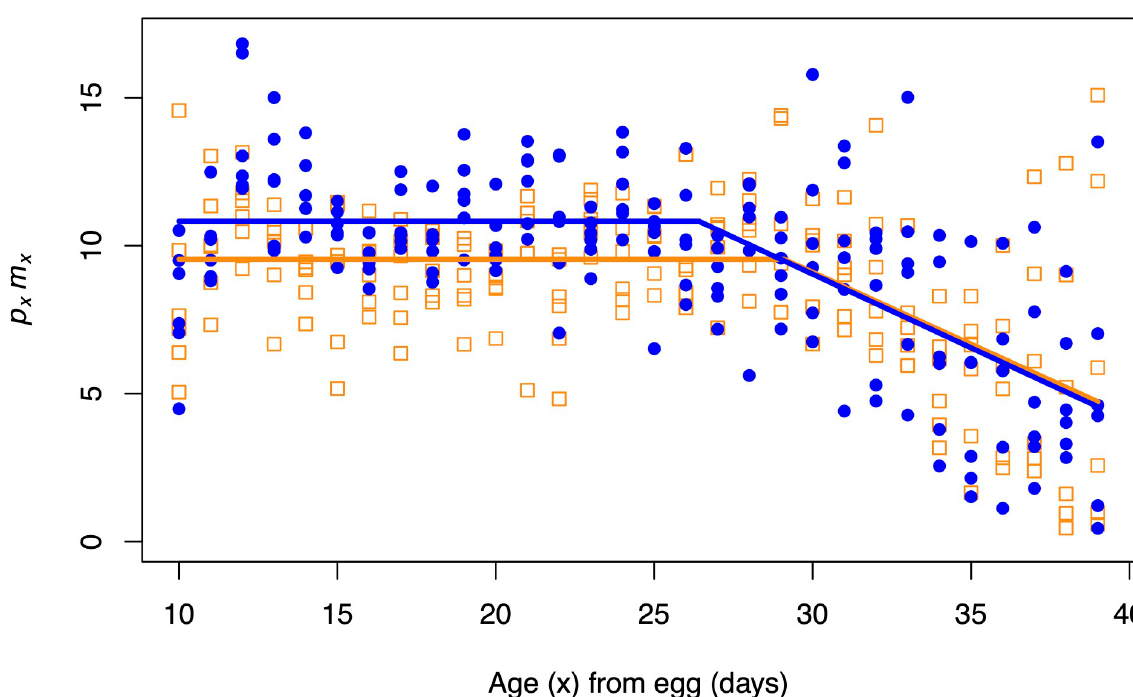
Fig 3. p results for the three ACO populations on the banana and orange diets. Closed blue circles and solid blue lines represent data x m x and regressions from the banana diet. Open orange squares and dotted orange lines represent data and regressions from the orange diet. A significant difference between diets in the intercept from the first stage ( a 0 ) was observed with flies on the orange diet not performing as well compared to the banana diet. In addition, there was no difference in the breakday ( a 2 ) between diets. Lastly, the second-stage slope ( a 1 ) was not significantly different between the two diets.